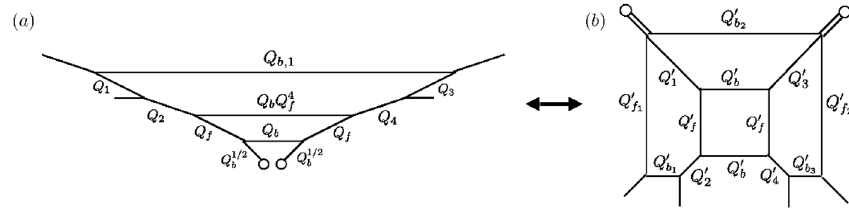
Figure 20 . The Hanany-Witten transition in the presence of the defect. Since the D7-brane is extended along a direction, the D7-brane affects the framing.